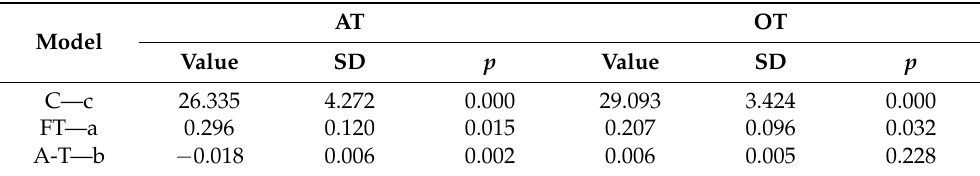
Table 2. Linear regression fitting parameter table of the forehead temperature, axillary temperature and oral